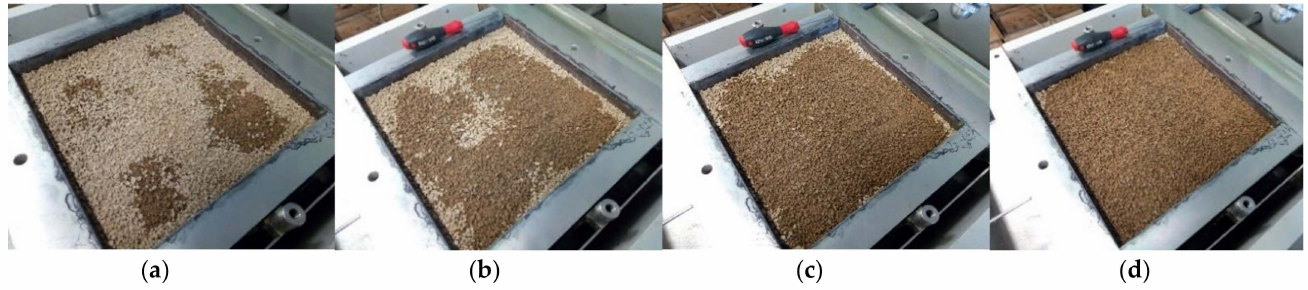
Figure 3. Saturation level within ( a ) 5 ( b ) 15 ( c ) 30 and ( d ) 45 min in the large shear box carriage by upwards water percolation through the flysch specimen